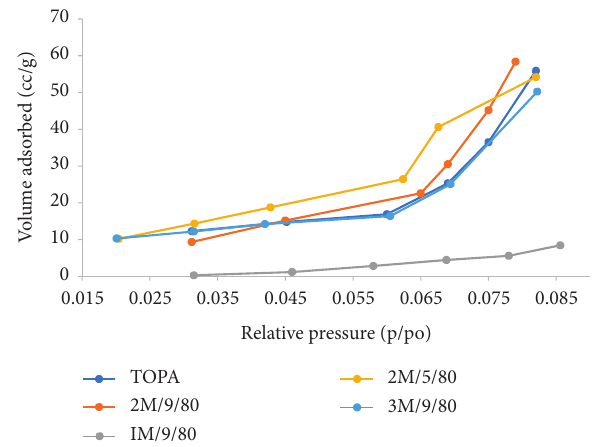
Figure 6: Relative pressure versus volume adsorbed for synthesized zeolite Y